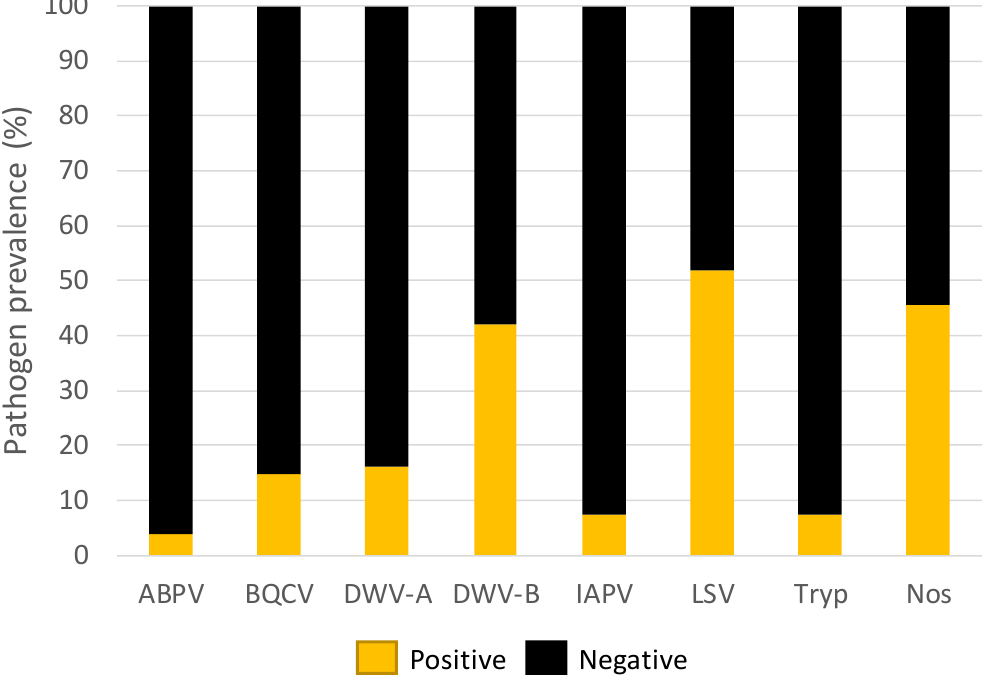
Figure 1. The percentage (%) of samples positive for pathogens detected within all the samples screened. Pathogens detected were Acute bee paralysis virus (ABPV), Black queen cell virus, (BQCV), Deformed wing virus-A and B (DWV-A & DWV-B), Israeli acute paralysis virus (IAPV), Lake Sinai virus (LSV), Trypanosomes (Tyrp) and Nosema (Nos).